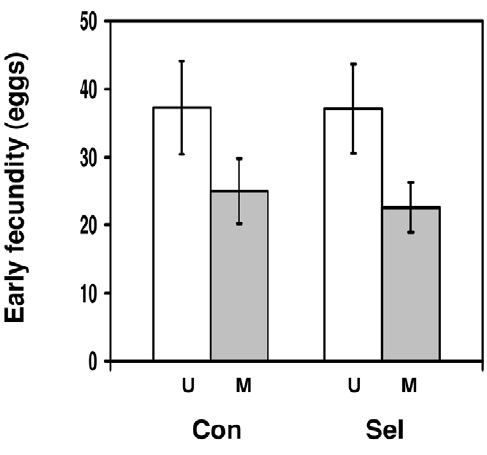
Figure 3. Fungal resistance of flies selected for parasitoid resistance. Mean time to death (in days) for Drosophila melanogaster adult flies that were either infected with Beauveria bassiana (F; grey bars) or uninfected (U; white bars), depending on whether they had been selected for increased resistance to Asobara tabida (Sel; right side of panel) or had not been selected (Con; left side of panel). Bars show mean 6 s.e.